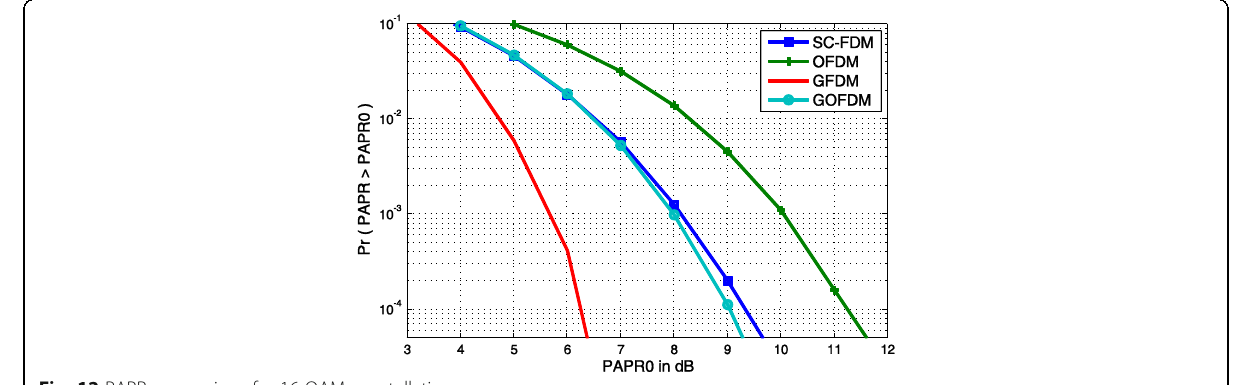
Fig. 12 PAPR comparison for 16-QAM